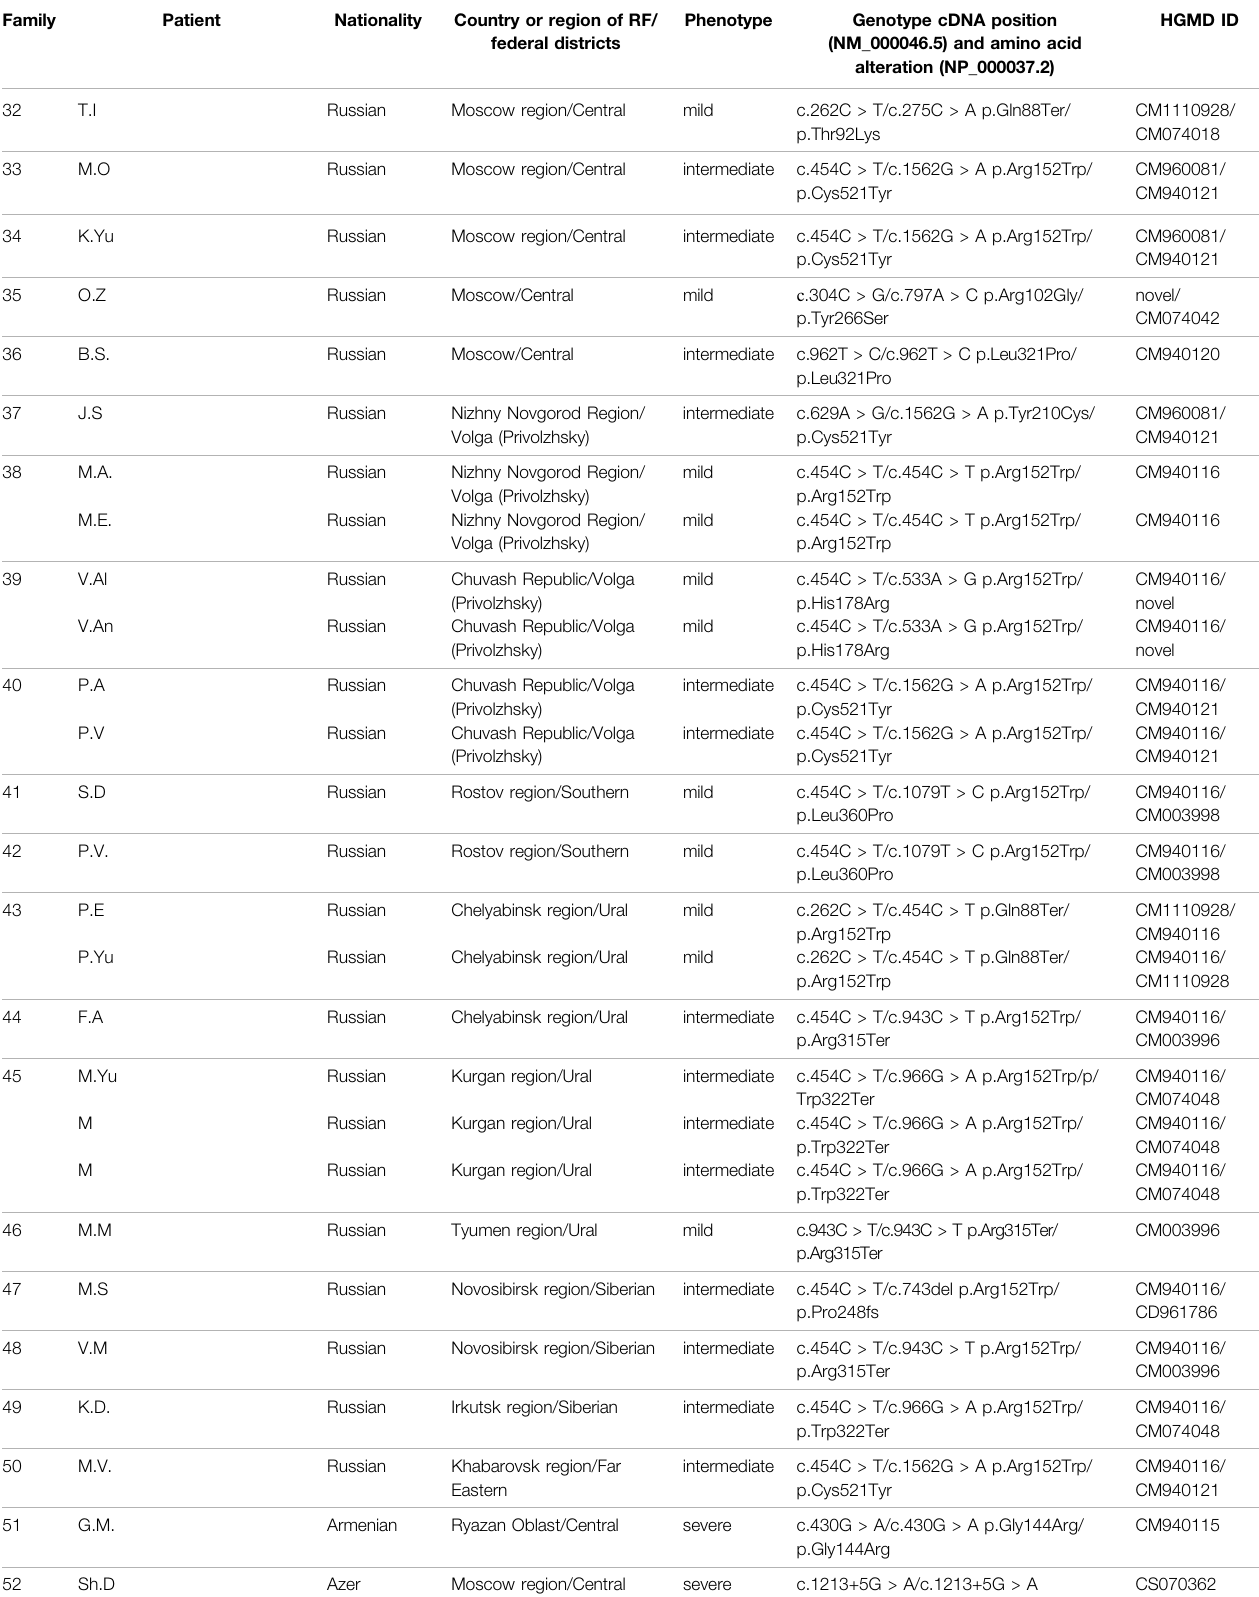
TABLE 1 | ( Continued ) Genotype and phenotype of patients with an indication of the place of residence and